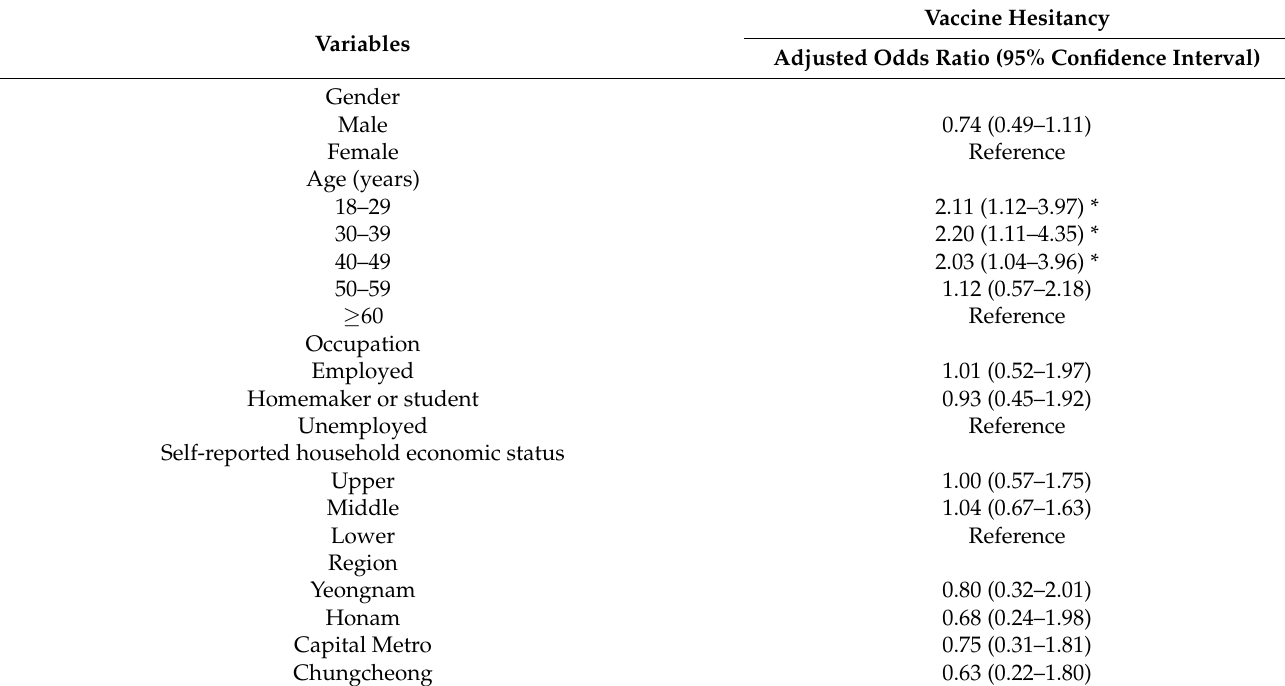
Table 2. Association between independent variables and vaccine